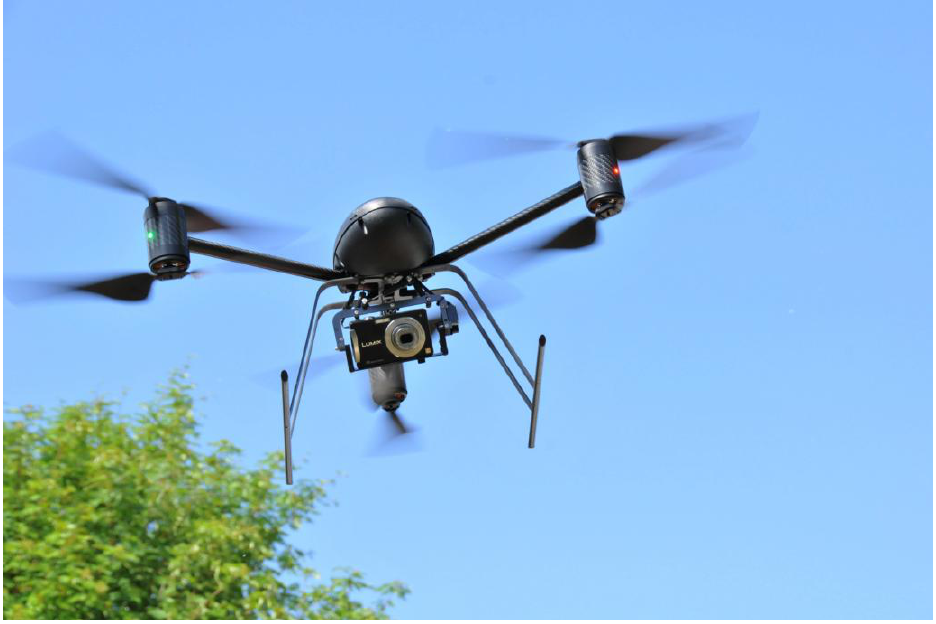
Figure 4. Draganflyer X6 VTOL UAS. Image courtesy Draganfly Innovations, Inc.